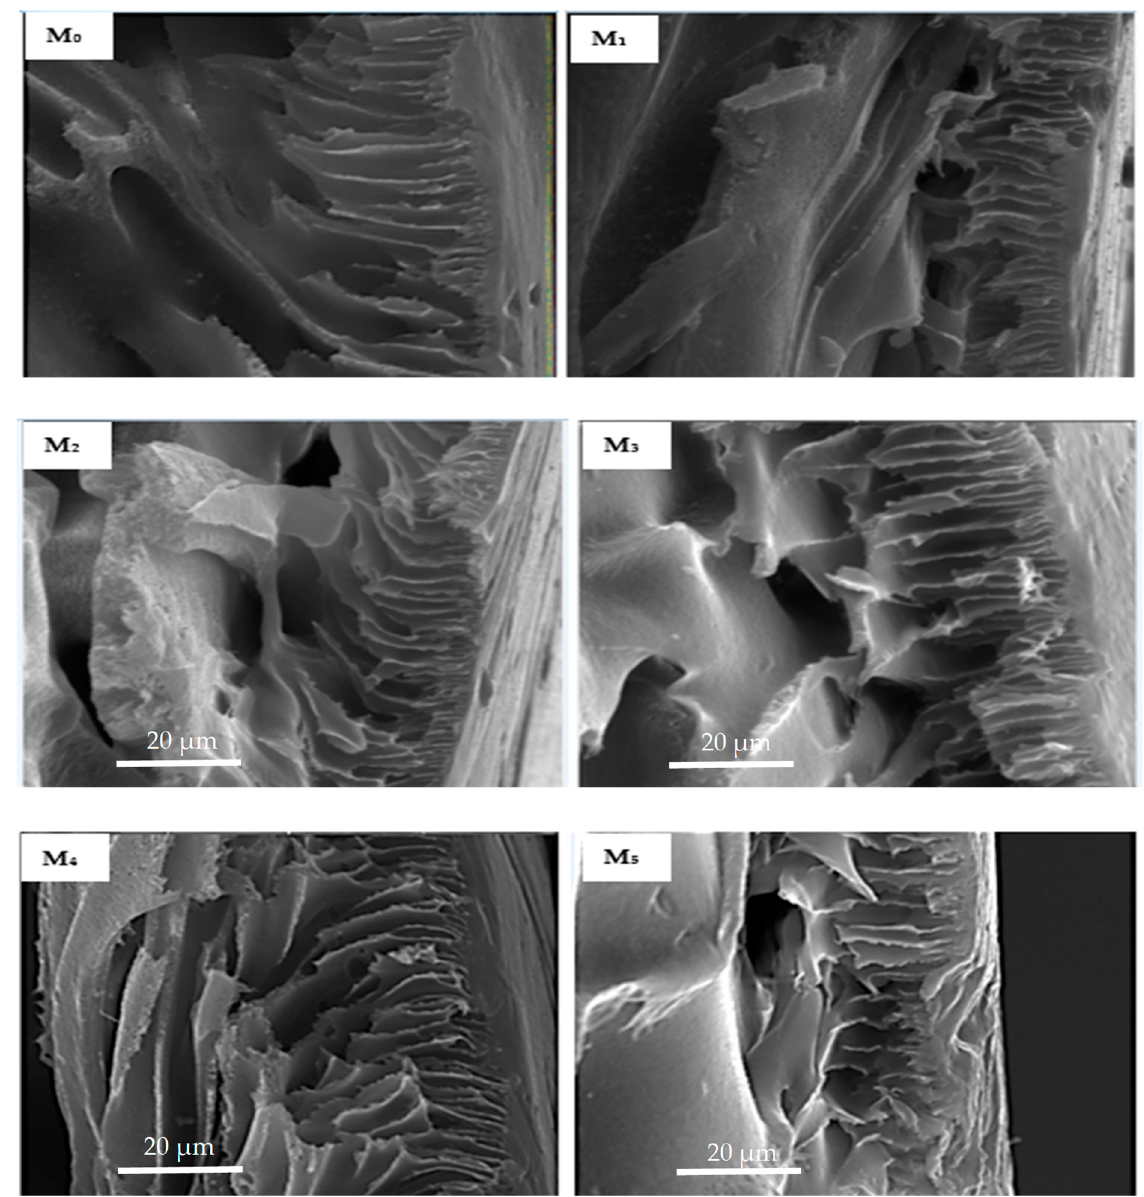
Figure 5. Cross-section SEM micrographs of membranes with varying amounts of PSN: (M 0 ) 0.00 wt %, (M 1 ) 0.05 wt %, (M 2 ) 0.10 wt %, (M 3 ) 0.30 wt %, (M 4 ) 0.50 wt %, and (M 5 ) 1.00 wt %.